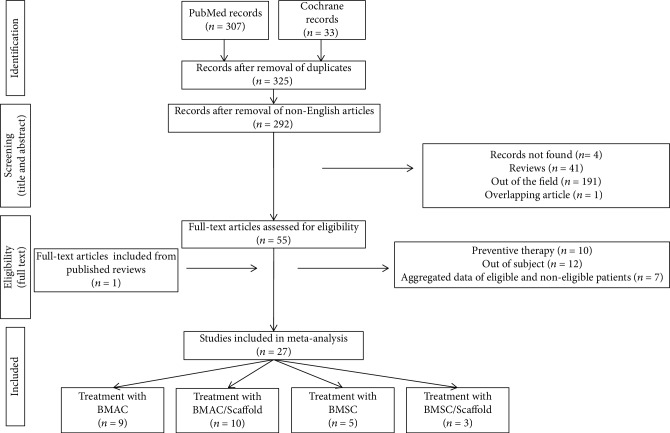
Flow diagram of the study selection process.